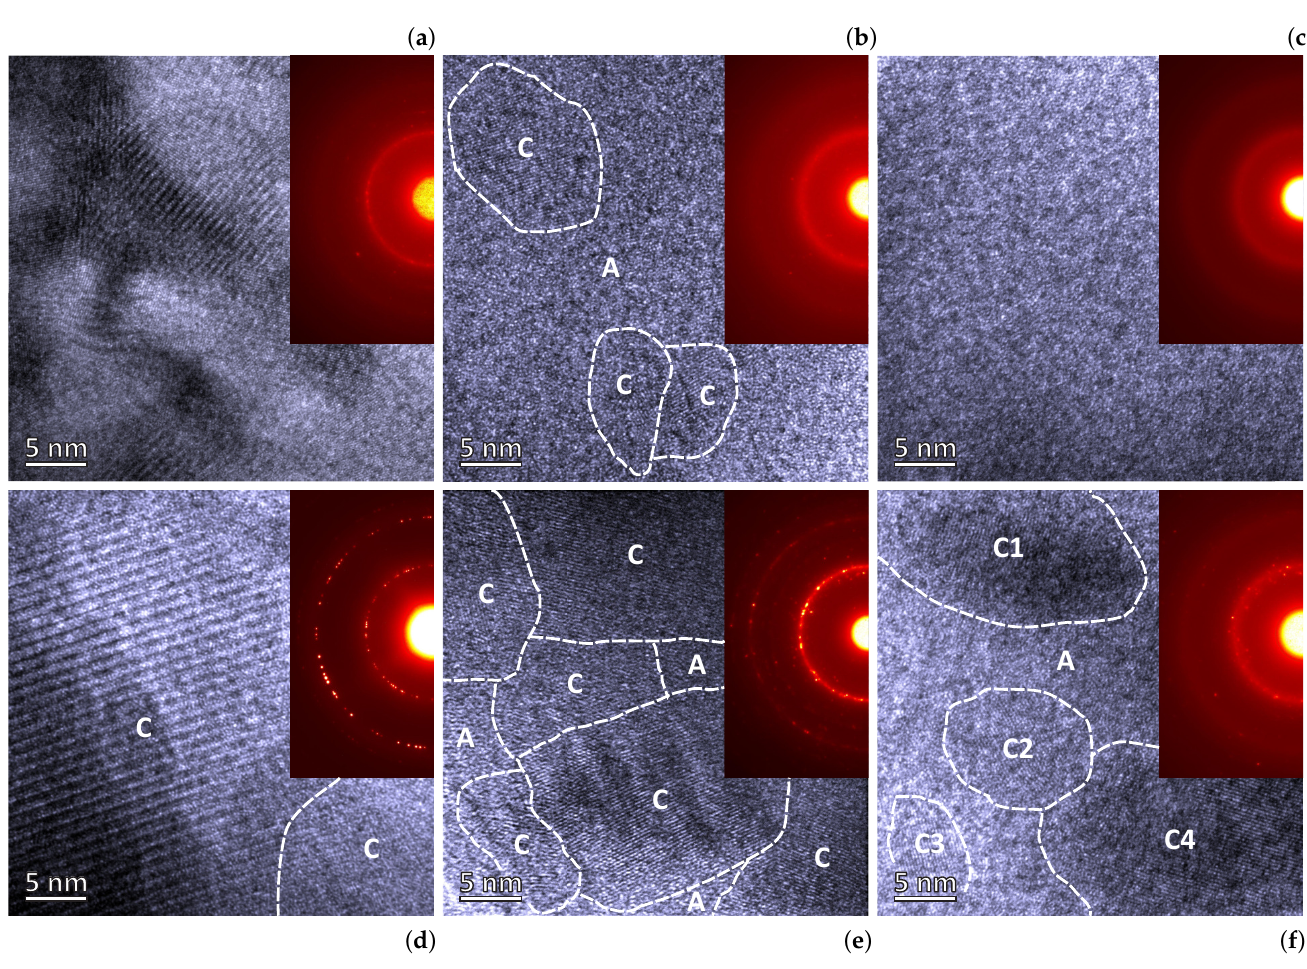
Figure 3. High-resolution TEM images with insets showing corresponding SAD patterns of CoFeTaB ( a – c ) and CoFeWB ( d – f ) alloys at various stages of mechanical alloying: ( a ) Ta-25 specimen with fully crystalline structure, ( b ) Ta-50 specimen shows traces of few nanocrystals, ( c ) Ta-100 appears completely amorphous, ( d ) W-25 specimen appears fully crystalline, ( e ) mostly crystalline structure of the sample W-50, and ( f ) mixture of nanocrystals and amorphous structure in the sample W-100. Amorphous and crystalline areas appearing in TEM images are labeled by letters A and C,